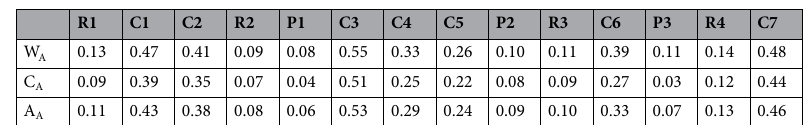
Table 3. Density of littered cigarette butt in locations (number/m 2 ). W A = Average in warm season, C A = Average in cold season, A A = Annual average.